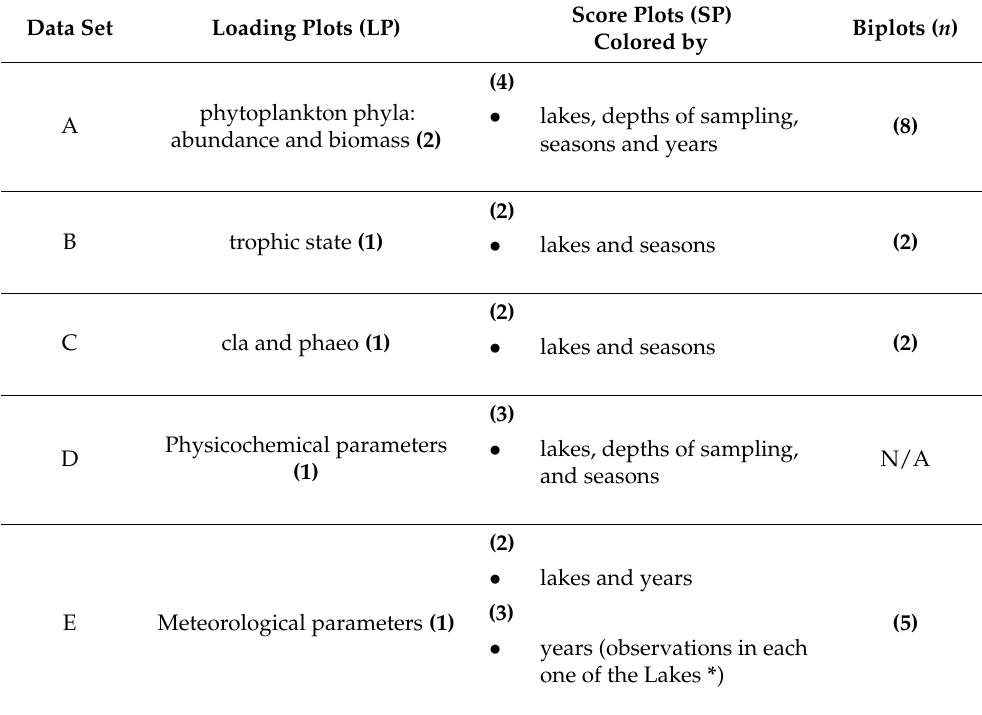
Table 3. A multivariate analysis plan of each single dataset.